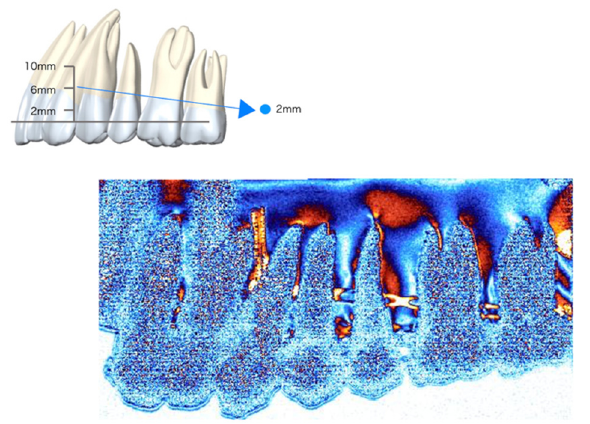
Figure 6. Six-millimeter retraction hook and 2 mm positioned posterior anchor model.